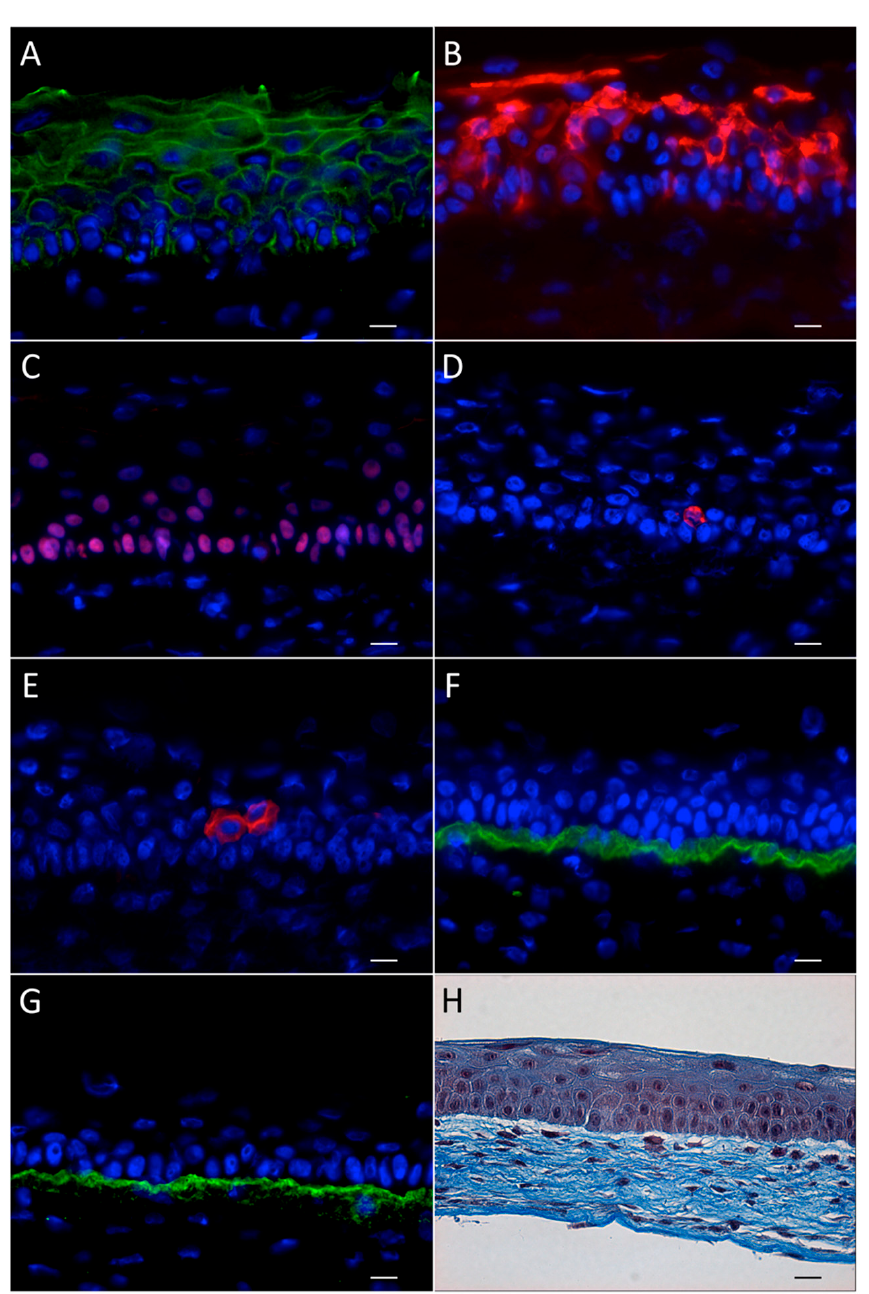
Figure 3. Characterization of the human tissue-engineered cornea. Immunofluorescence analysis of: ( A ) the epithelial barrier marker ZO-1, ( B ) the differentiation marker keratins K3/K12, ( C ) the epithelial cell marker p63, ( D ) the cornea epithelial stem cell marker ∆ Np63 α , and ( E ) K19, ( F ) the epithelial basement membrane components laminin V, and ( G ) collagen IV. ( H ) Nuclei were counterstained with Hoechst 33,258 reagent and appear in blue. Scale bar: 20 µ m. Histology (Masson’s Trichrome staining) of the tissue-engineered cornea, showing an epithelium adhered to the self-assembled stromal matrix. The 5–6 epithelial cell layers differentiate during their upward migration. The scale bar in H equals 20 µm.